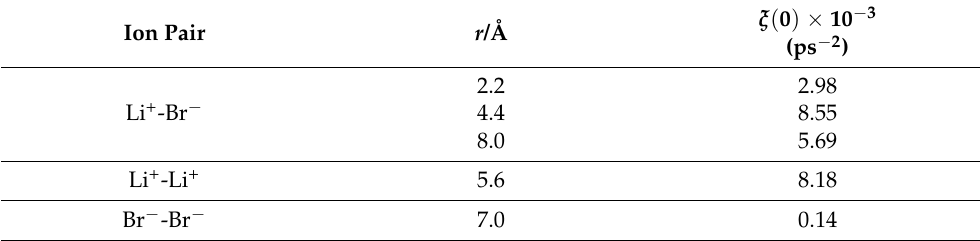
Table 9. Initial values of the friction kernels for all ion pairs and interionic separations. Ion